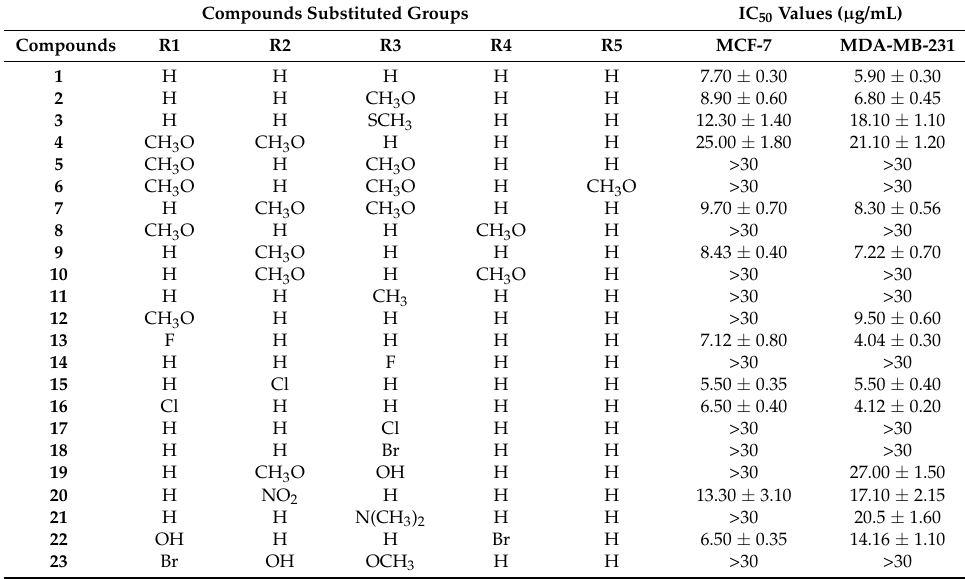
Table 2. IC 50 values ( µ g/mL) of FKB derivatives after 72 h